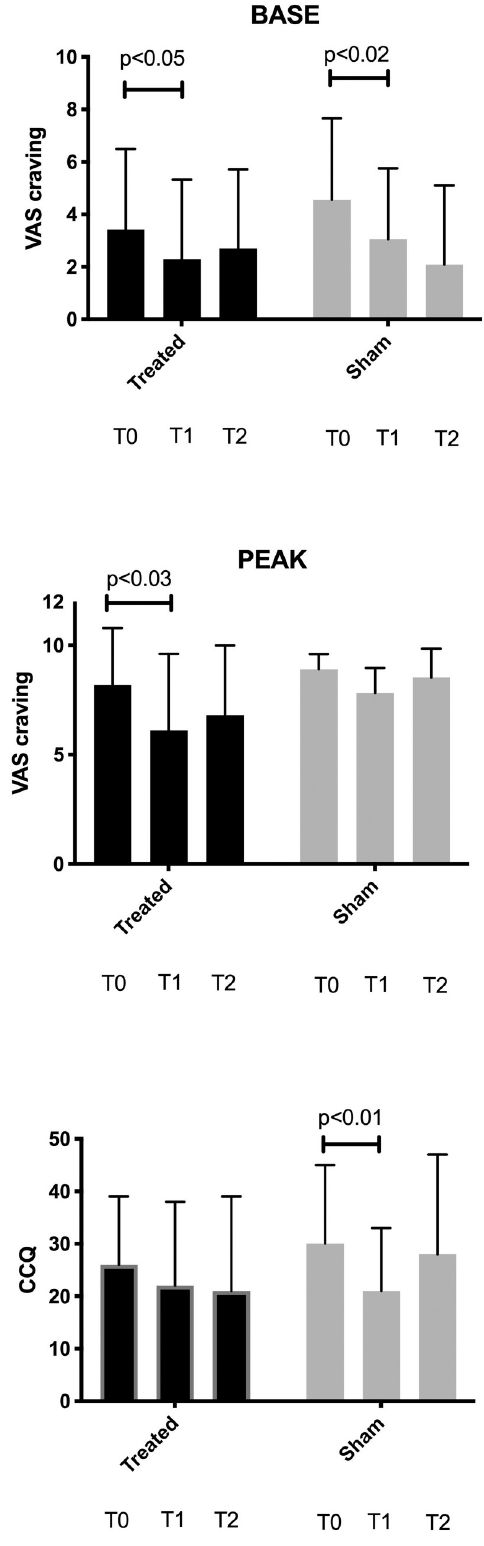
Fig 4. Craving scales. VAS (basal and peak) and CCQ (mean and SD) in the rTMS treated and sham-treated groups at T0, T1, and T2. The Wilcoxon signed-rank test evaluated differences.